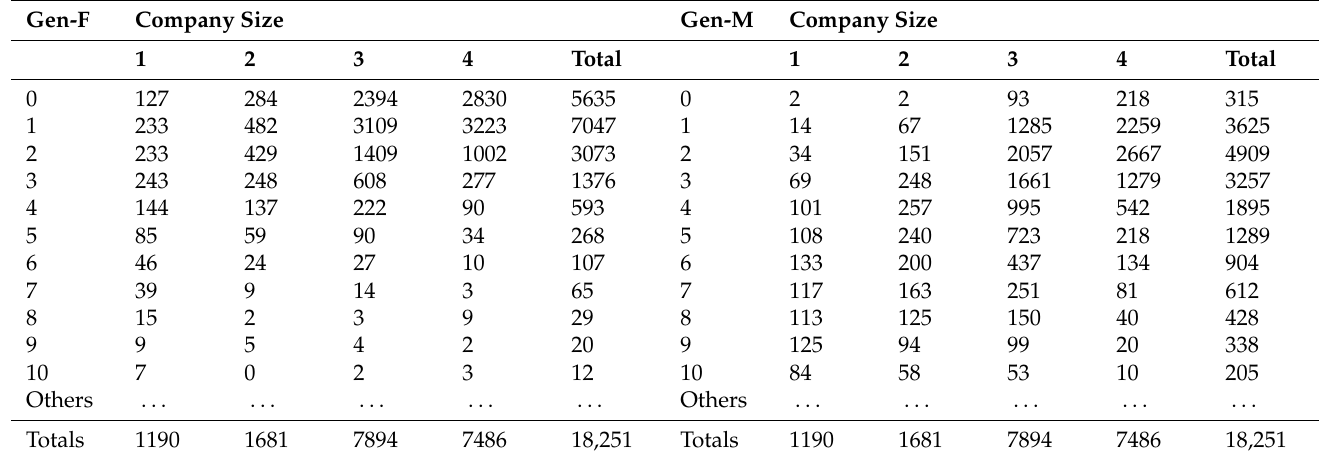
Table 7. Number of board members of each gender by company